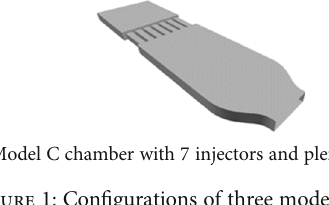
Figure 1: Con fi gurations of three model